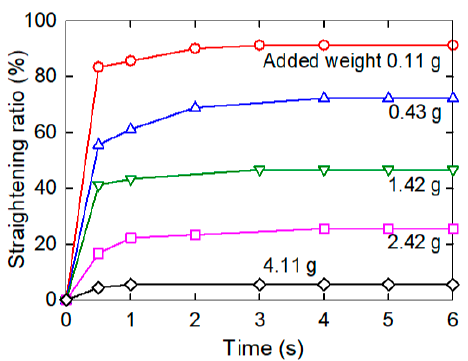
Figure 9. The time course of the straightening of the epoxy strips loaded with indicated weights at 47 °C.